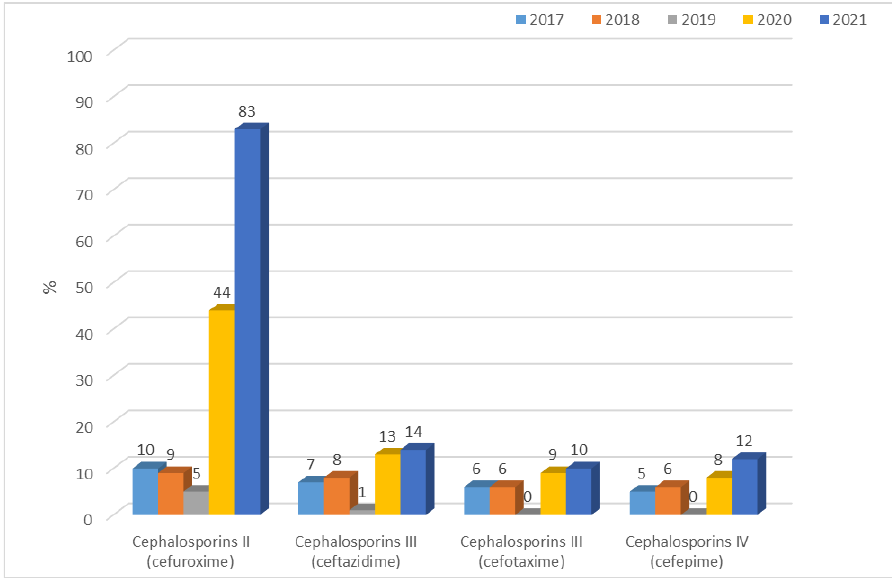
Figure 15. Percentage of cephalosporin-resistant K. pneumoniae ESBL(−) strains.